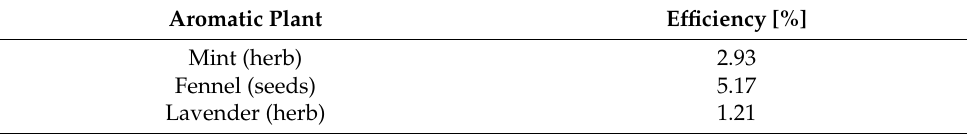
Table 1. Volatile oil extraction